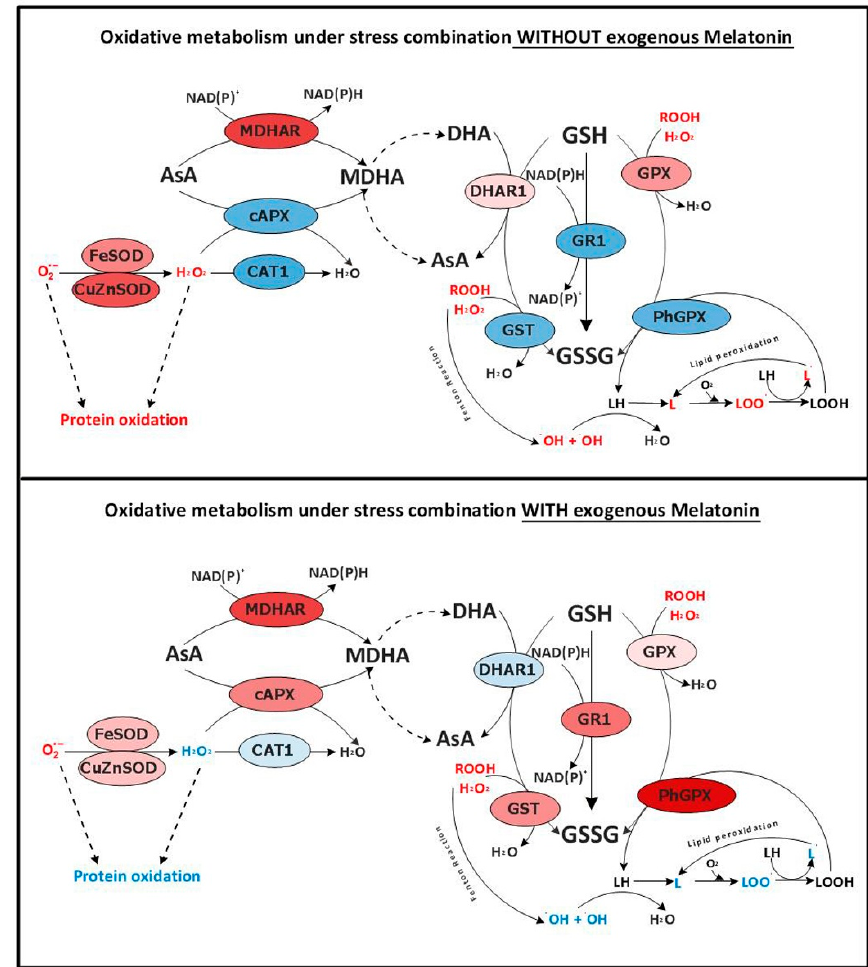
Figure 7. Schematic comparison of the changes observed in the oxidative metabolism pathway with or without melatonin pre-treatment in tomato plants grown under the combination of salinity and heat (based on the results showed in Figure 6).